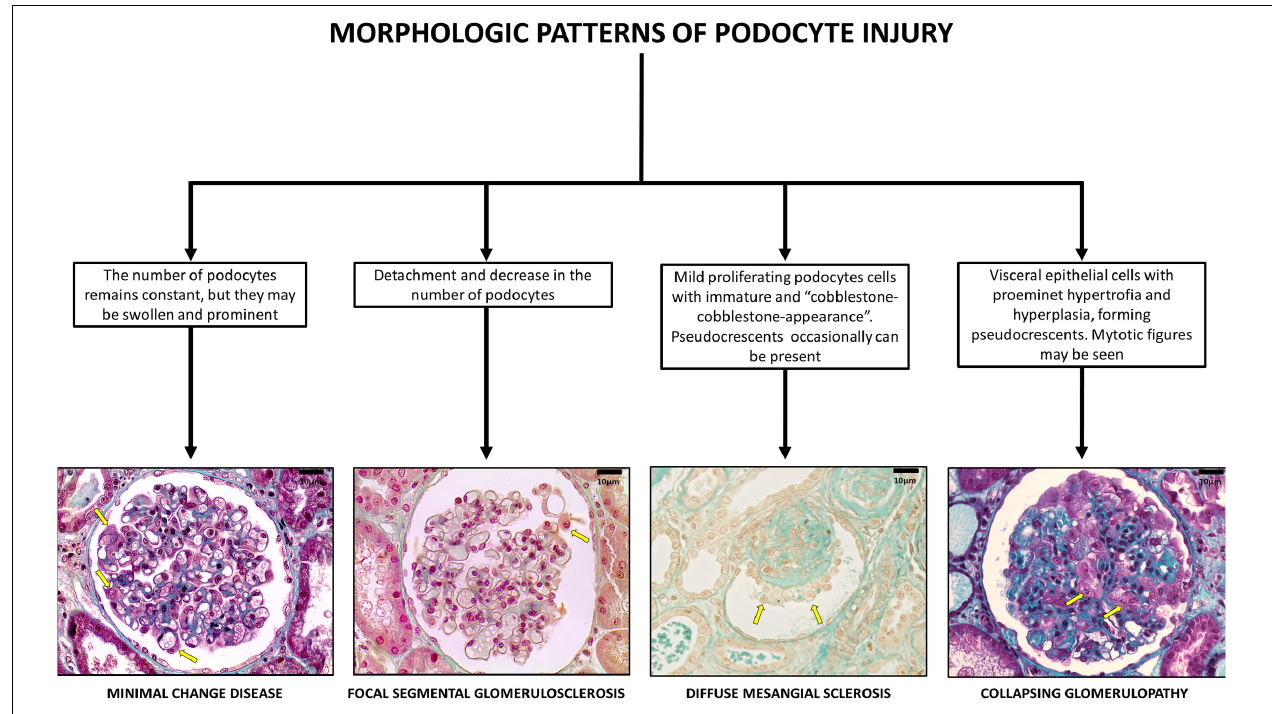
FIGURE 1 | Glomerular pattern and podocytes morphological changes in human podocytopathies (bar = 10 µ m).